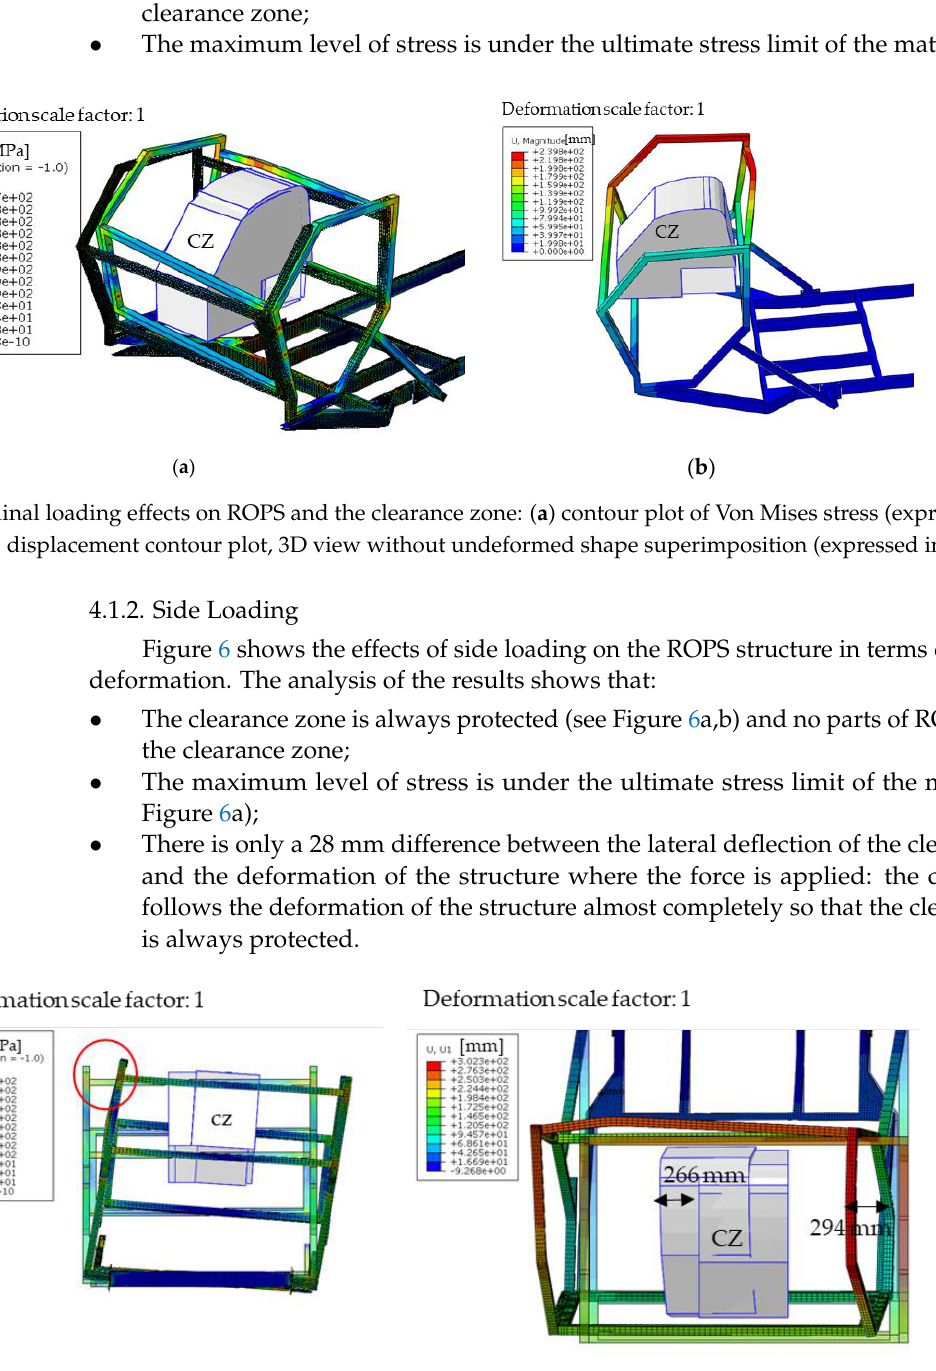
Figure 6. Side loading ROPS and clearance zone: ( a ) rear-view contour plot of Von Mises stress (expressed in MPa); ( b ) top-view displacement contour plot (expressed in mm).